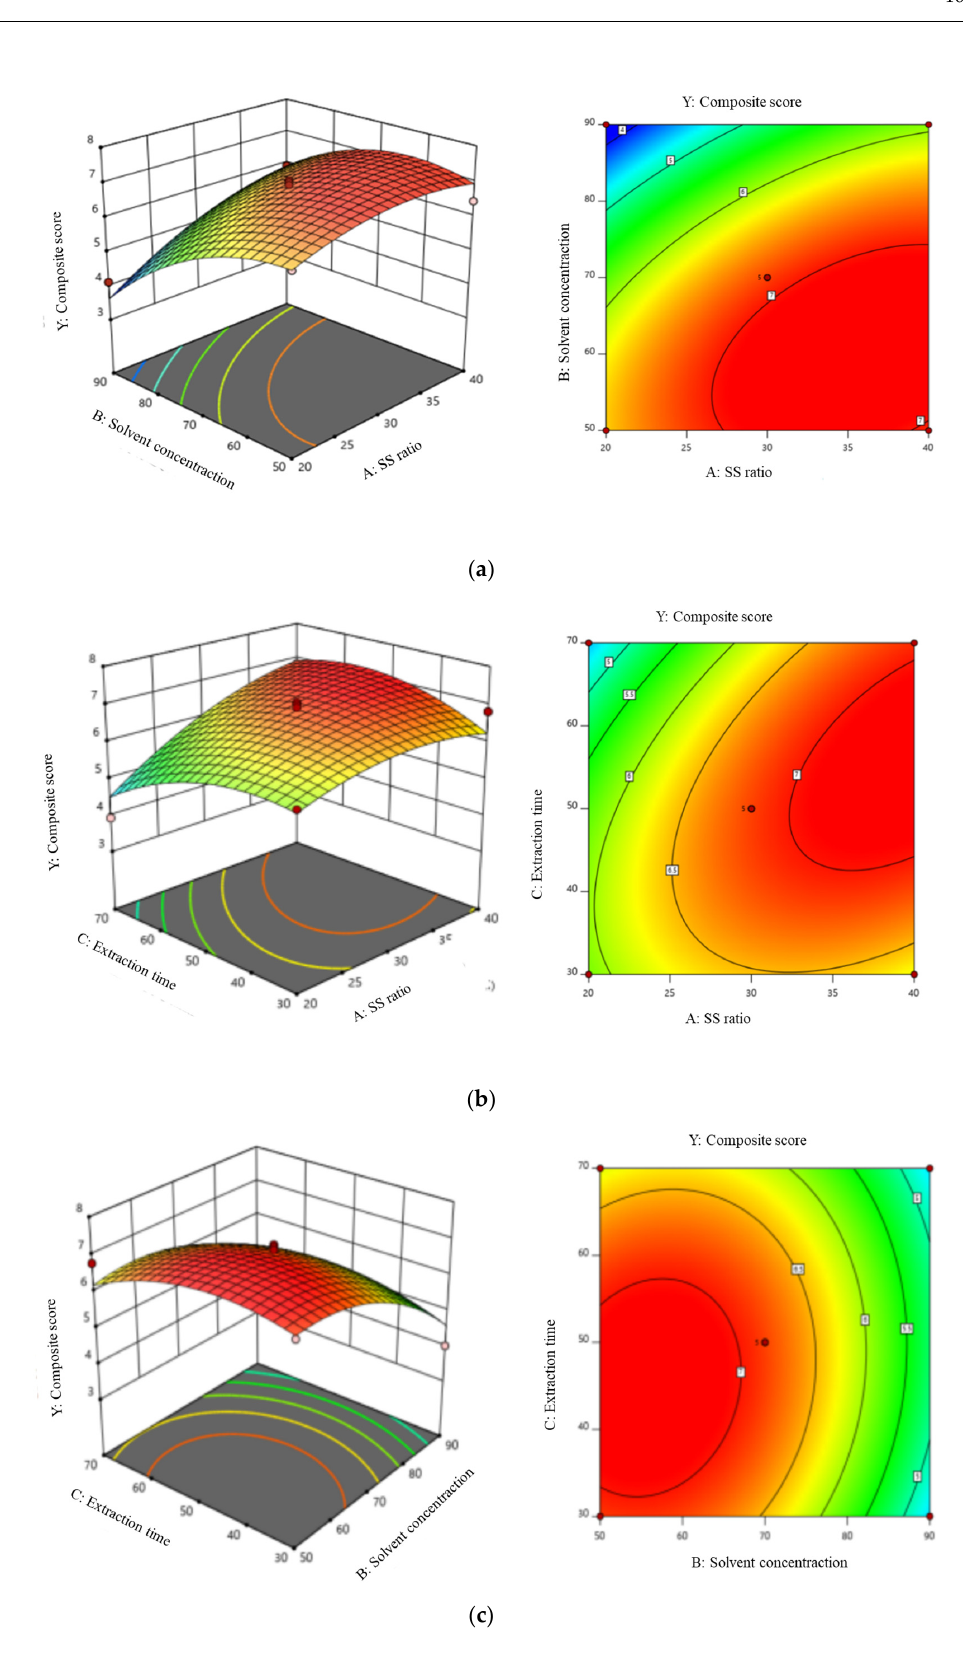
Figure 4. Response surface and counter plots showing the interaction effect on the extraction yield of flavonoids. ( a ): response surface graph of solvent concentration(B) and SS ratio(A); ( b ): response surface graph of extraction time(C) and SS ratio(A); ( c ): response surface graph of solvent concentra- tion(B) and extraction